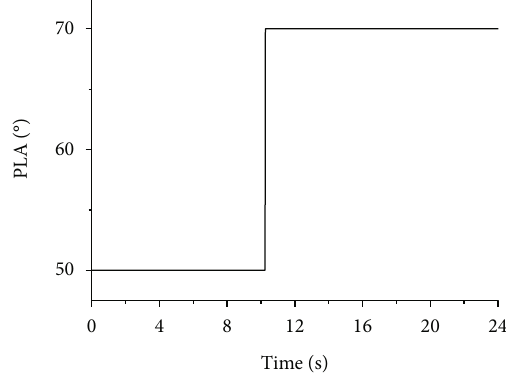
Figure 14: Change of the throttle lever